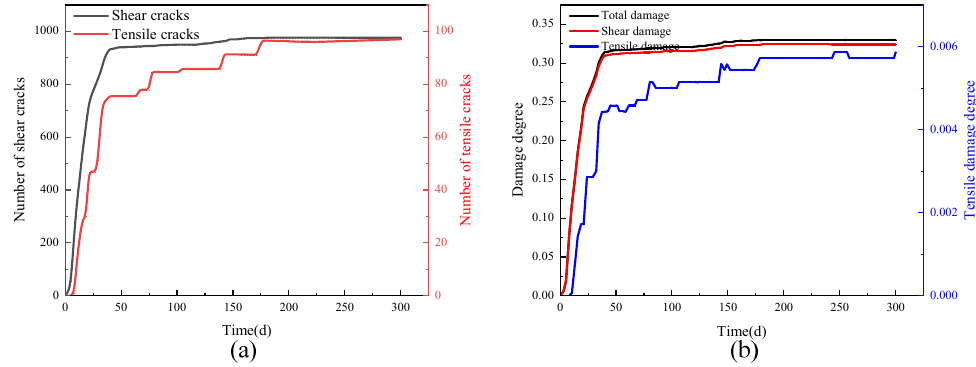
Figure 17. Evolutions of number of cracks and damage degree with time after support optimization. ( a ) number of cracks; ( b ) damage